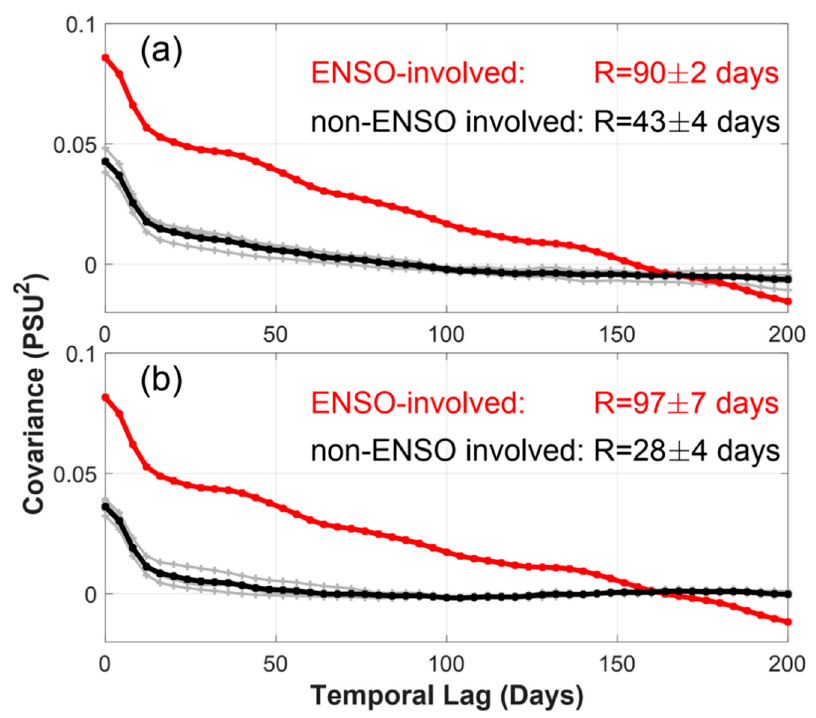
Figure 3. ( a ) Temporal autocovariance functions of SSS variability in the Niño 4 region. The red curve corresponds to the SSS time series from January 2015 to December 2016. The gray curves indicate the time series over 2011–2012, 2013–2014, 2017–2018, 2019–2020, and the black curve represents their ensemble-mean. As mentioned in Section 2.2.1, the temporal scale is defined as the e-folding decorrelation scale of the Gaussian function (not shown) fitted to the autocovariances. The region where the autocovariances are computed is indicated by the yellow rectangle in Figure 2. ( b ) as in ( a ) but with the annual cycle removed.